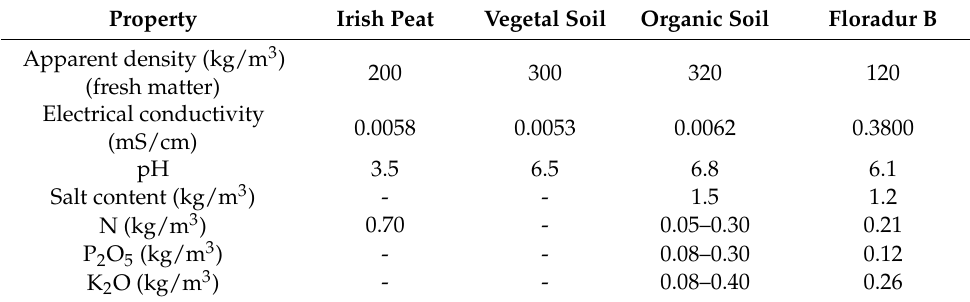
Table 1. Substrates properties as indicated by the different manufacturers.